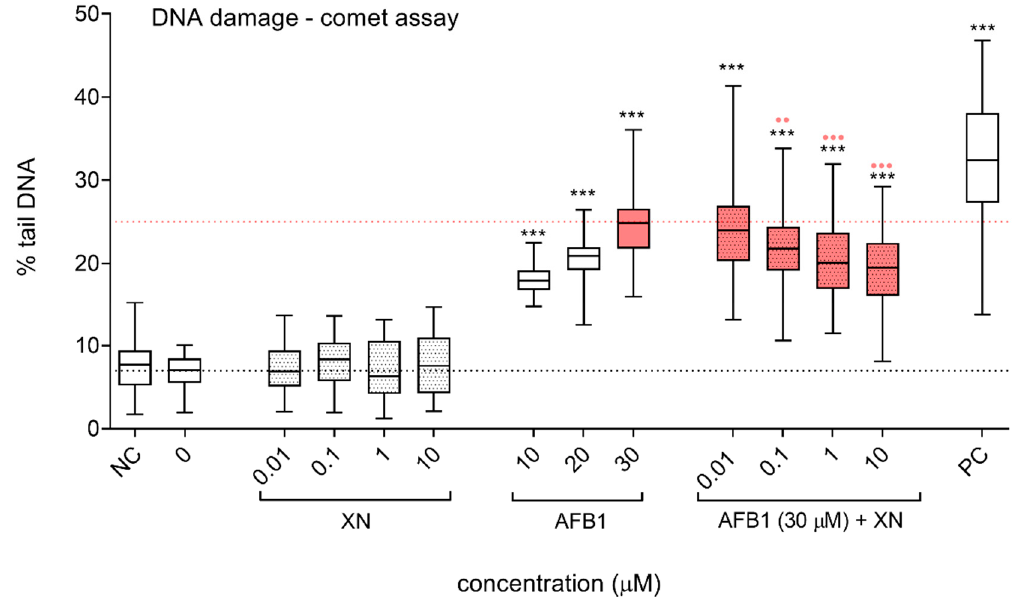
Figure 6. Protective effects of XN against AFB1 ‐ induced DNA strand breaks. The effects of XN (0.01, 0.1, 1, and 10 μ M), AFB1 (10, 20, and 30 μ M) and the AFB1 (30 μ M)—XN (0.01, 0.1, 1, and 10 μ M) combinations on DNA damage induction after 24 h of exposure. Data are expressed as % of “comet tail” DNA. 0 is the solvent control (1% DMSO).NC is the negative control (growth medium). PC is the positive control—BaP (30 μ g/mL). The lower dashed line represents the median value of the % tail DNA in the solvent control. The upper red dashed line represents the median % of tail DNA in the cell population exposed to AFB1 (30 μ M). The asterisks (*) denote a statistically significant difference (Kruskal–Wallis nonparametric test and Dunn’s multiple comparison test) between the solvent control and the AFB1, XN, and their combinations exposed cells (*** p ≤ 0.001). The red dots (•) denote a statistically significant difference (Kruskal–Wallis nonparametric test and Dunn’s multiple comparison test) between the cells exposed to AFB1 (30 μ M) and to the AFB1 ‐ XN combinations (•• p ≤ 0.01; ••• p ≤ 0.001).